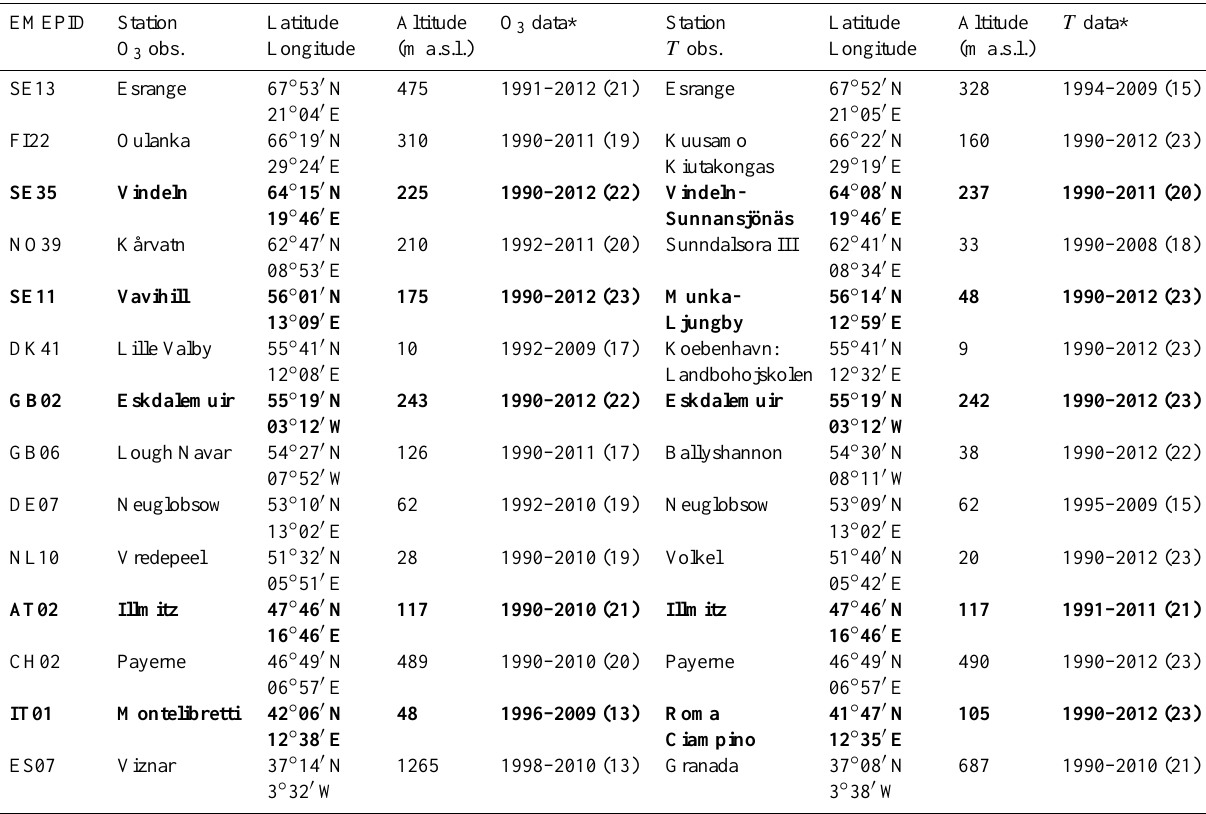
Table 1. Description of the 14 EMEP monitoring sites with O 3 observations and nearby temperature ( T ) observations included in the comparison between observations and simulations. The five stations used for POD 1 calculations are marked in